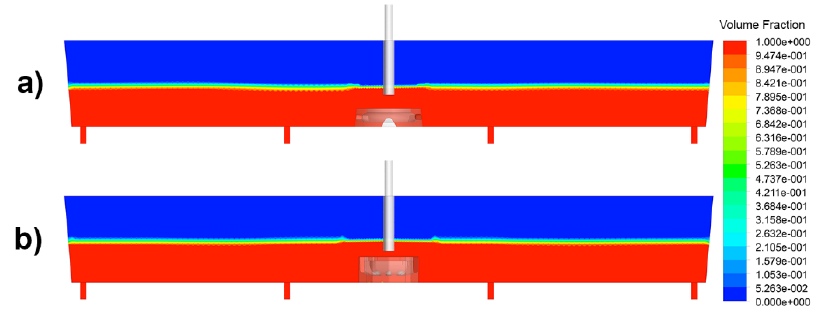
Figure 10. Stability of the gas–liquid interface during the tundish filling, presented as volume fractions of liquid (red) and gas (blue): ( a ) TI1; ( b ) TI3.